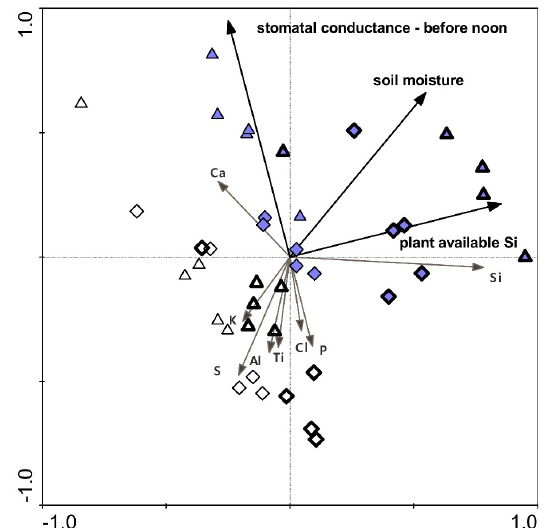
Figure 6. Redundancy analysis plot showing the strength of associations between some of the wa- ter availability indicators (soil moisture during water shortage and stomatal conductance during water shortage before noon) along with plant-available Si level in the soil after Si treatment, and leaf element contents. Symbol characteristics: diamonds, UV–; triangles, UV+; thick line, Si+; thin line, Si–; blue, W+; white, W–.